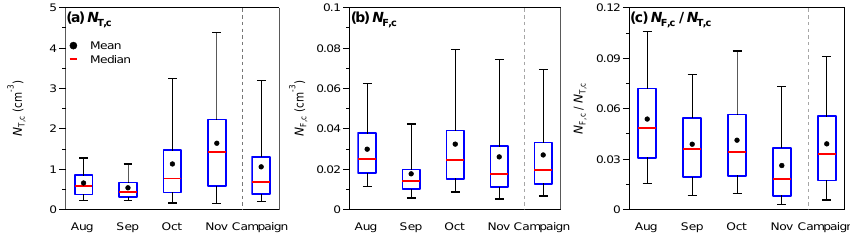
Fig. 2. Statistical distribution of integrated coarse TAP and FBAP number concentrations (1–20µm) measured during each month (August– November) and over the full campaign as box-whisker plots. Black dot represents arithmetic mean, red bar represents median (50th per- centile), lower and upper limits of blue box represent 25th and 75th percentiles, respectively. Horizontal bars at the end of lower and upper vertical bars represent 5th and 95th percentiles, respectively. (a) N T , c , (b) N F , c , (c) N F , c / N T , c .